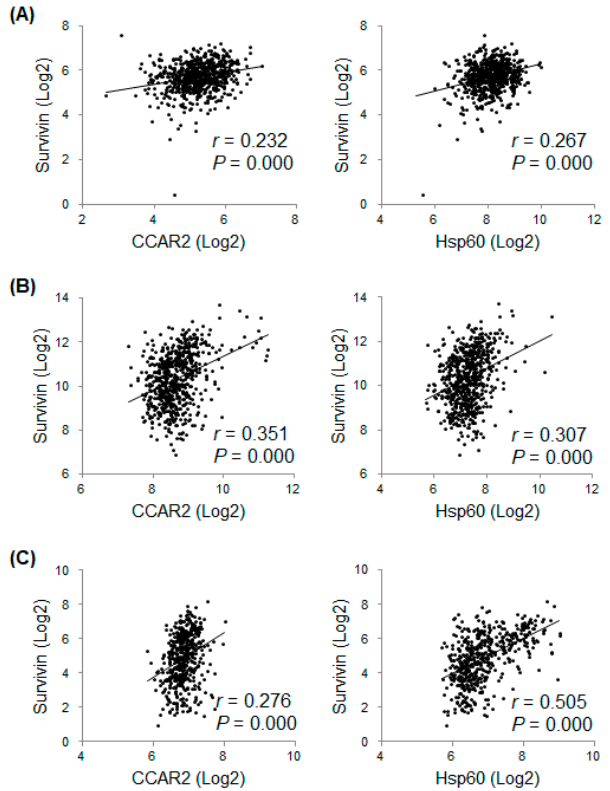
Figure 4. Expression of survivin mRNA in human cancer cell lines and neuroblastoma tissues shows a positive correlation with that of CCAR2 and Hsp60. Expression of mRNAs encoding